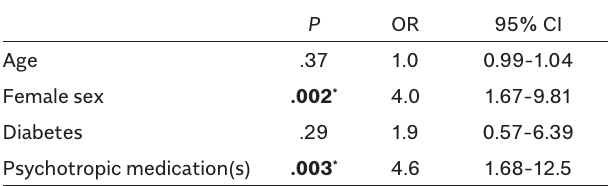
Table 3. Multivariate Analysis of PGTT Risk